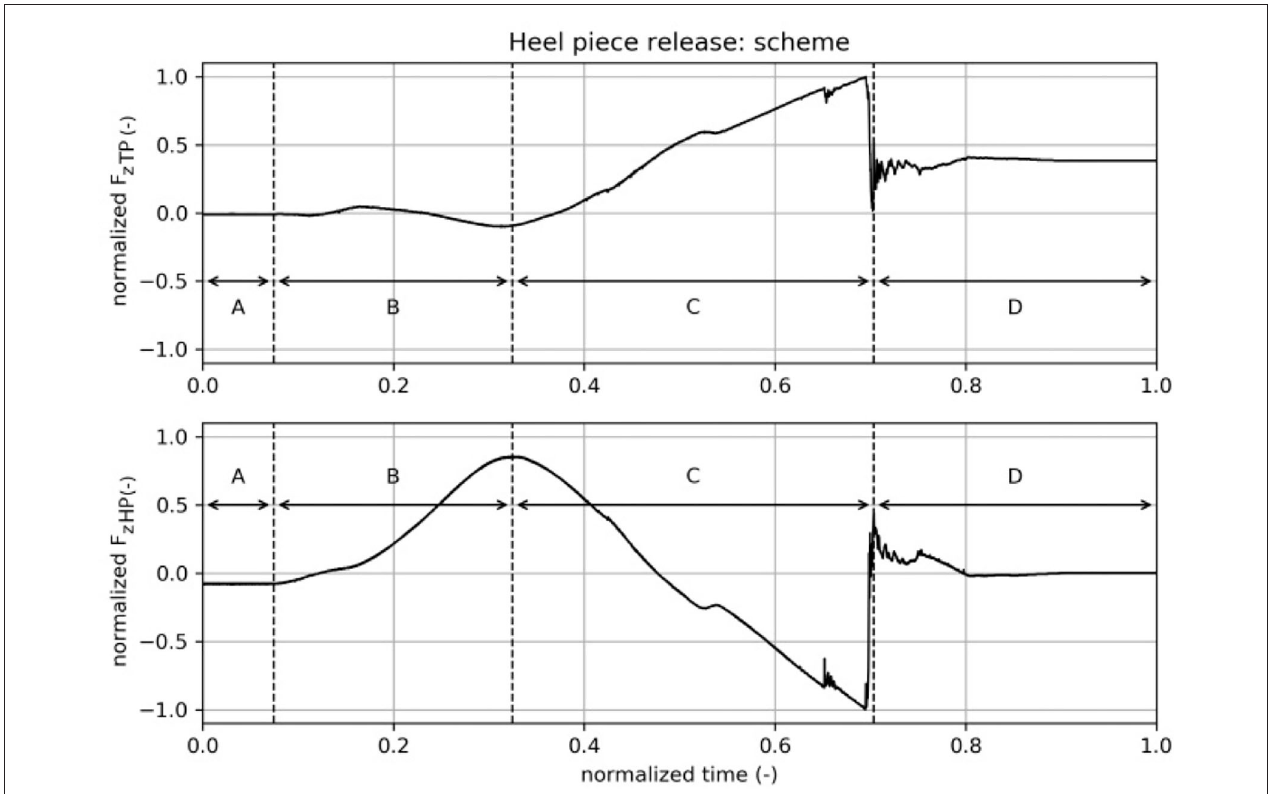
FIGURE 4 | Heel piece release motion scheme, time signals: A—boot rests in binding, B—deflection of ski, C—boot heel moves up, D—boot released.